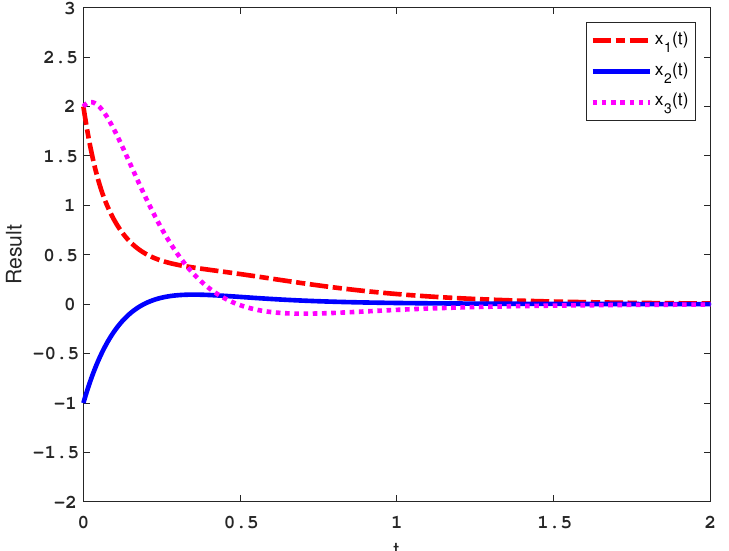
Figure 9. The time response curves of the controlled Chua’s oscillator with periodically intermittent control with variable control